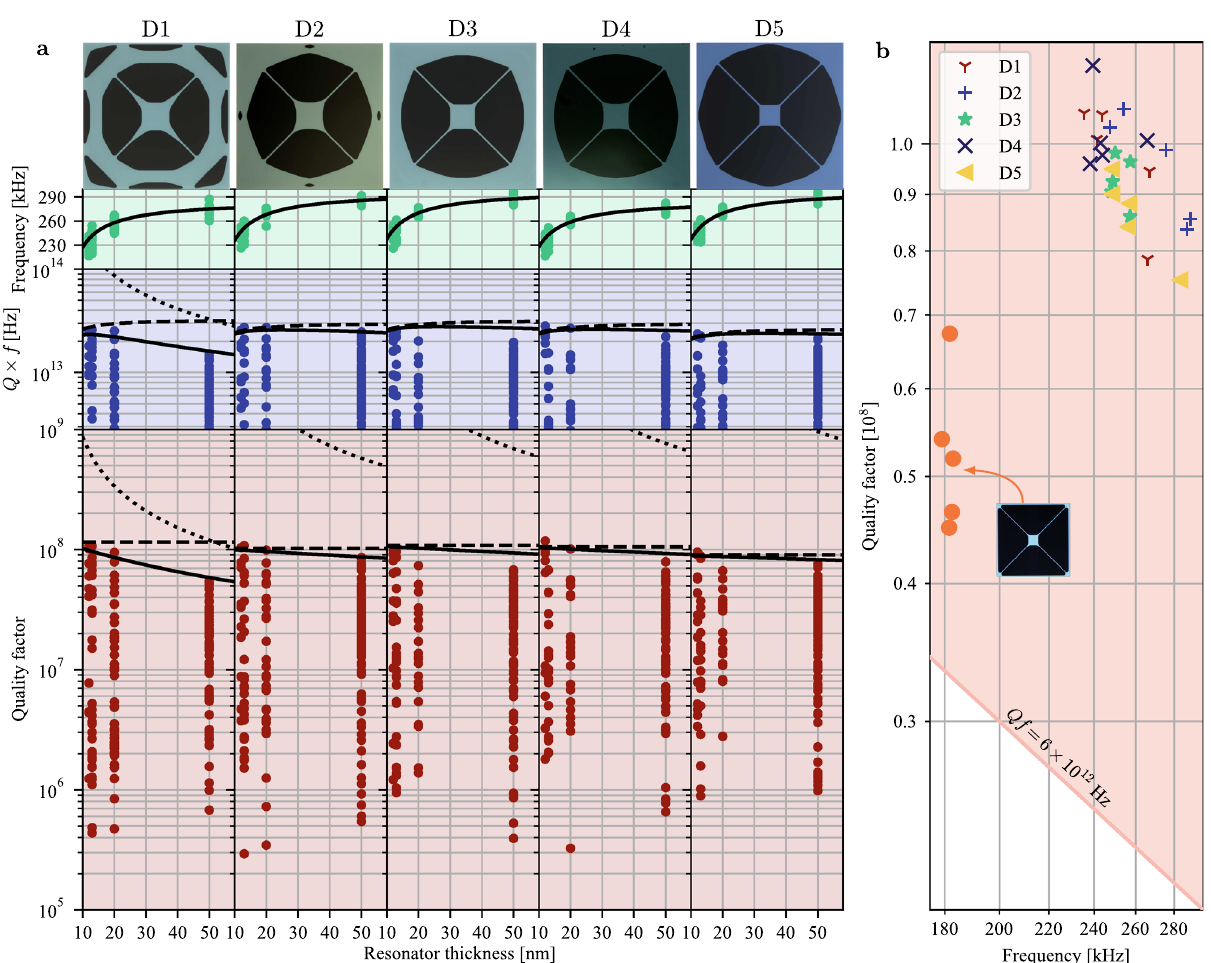
Fig. 3 Results overview. a Overview of the measured frequencies and quality factors across all designs and thicknesses together with selected microscope images. Solid lines correspond to theory fi tted to the measured frequencies and best attained quality factors. Dotted and dashed lines are associated with the phonon tunneling and intrinsic loss contributions, respectively. For some designs, the theory curves for the phonon tunneling loss is not visible on the plots. b Quality factor plotted against frequency for the fi ve best samples for each design. The shaded area marks the parameter regime in which the resonator may undergo quantum coherent oscillations at room temperature. The inset is the nominal trampoline design fabricated in this work and used as a reference 13 . The large spread in the Q factors is due to the uncontrollable coupling of the fundamental mode to the substrate mode. In the Qf plot, we only include measurements of membranes for which the Q factor was above 10 7 but all measurement data are included in the plots for the frequency and Q factor.